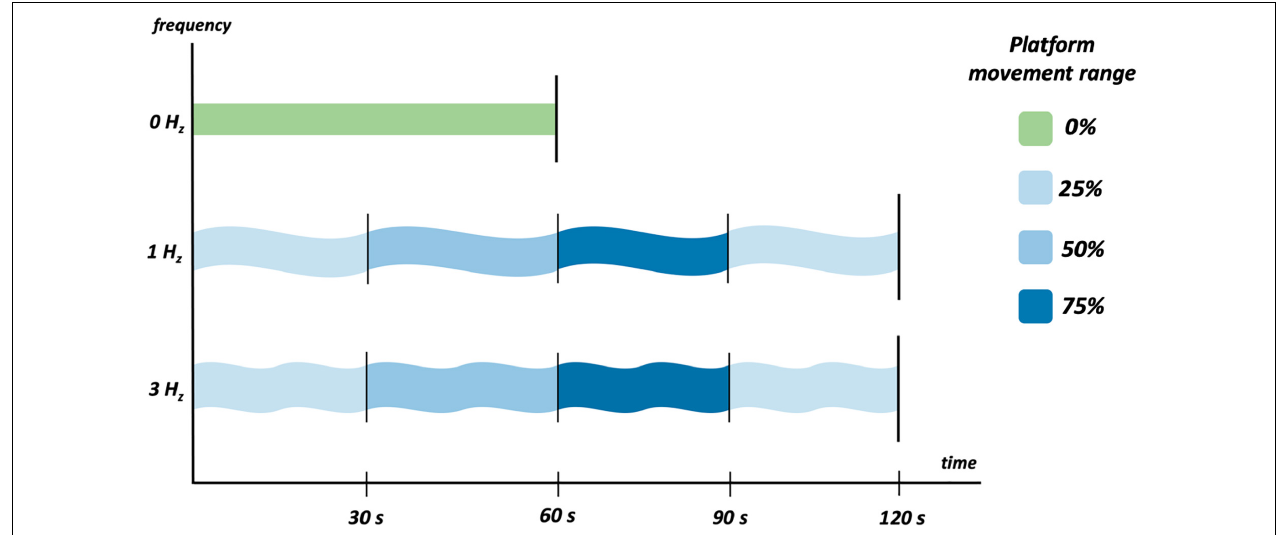
FIGURE 2 | The three acquisition protocols that each patient has been subjected